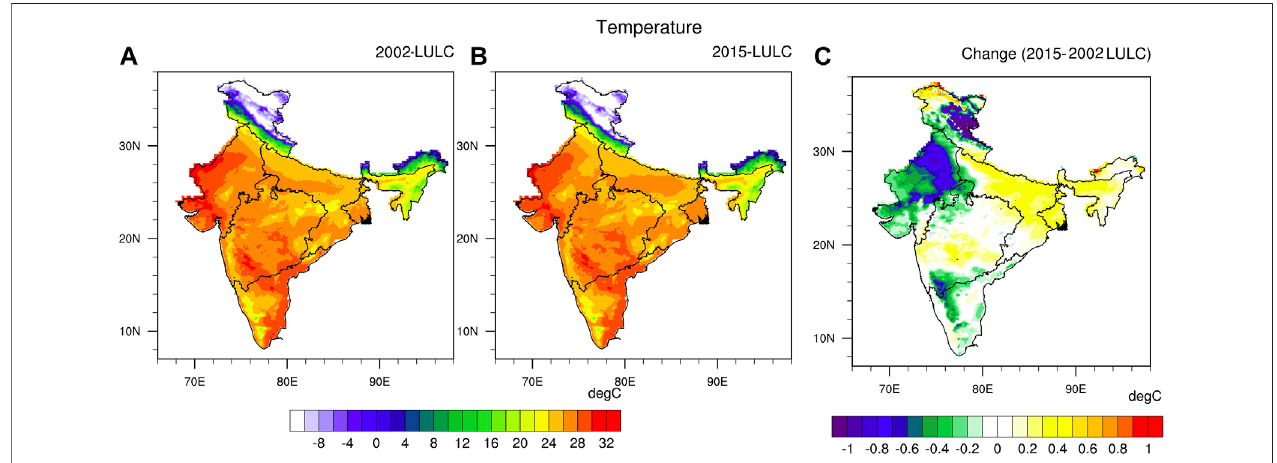
FIGURE 6 | Mean temperature simulation (mean of 2010 – 2015) based on (A) LULC-2002, (B) LULC-2015, and (C) the change between two LULC simulations.